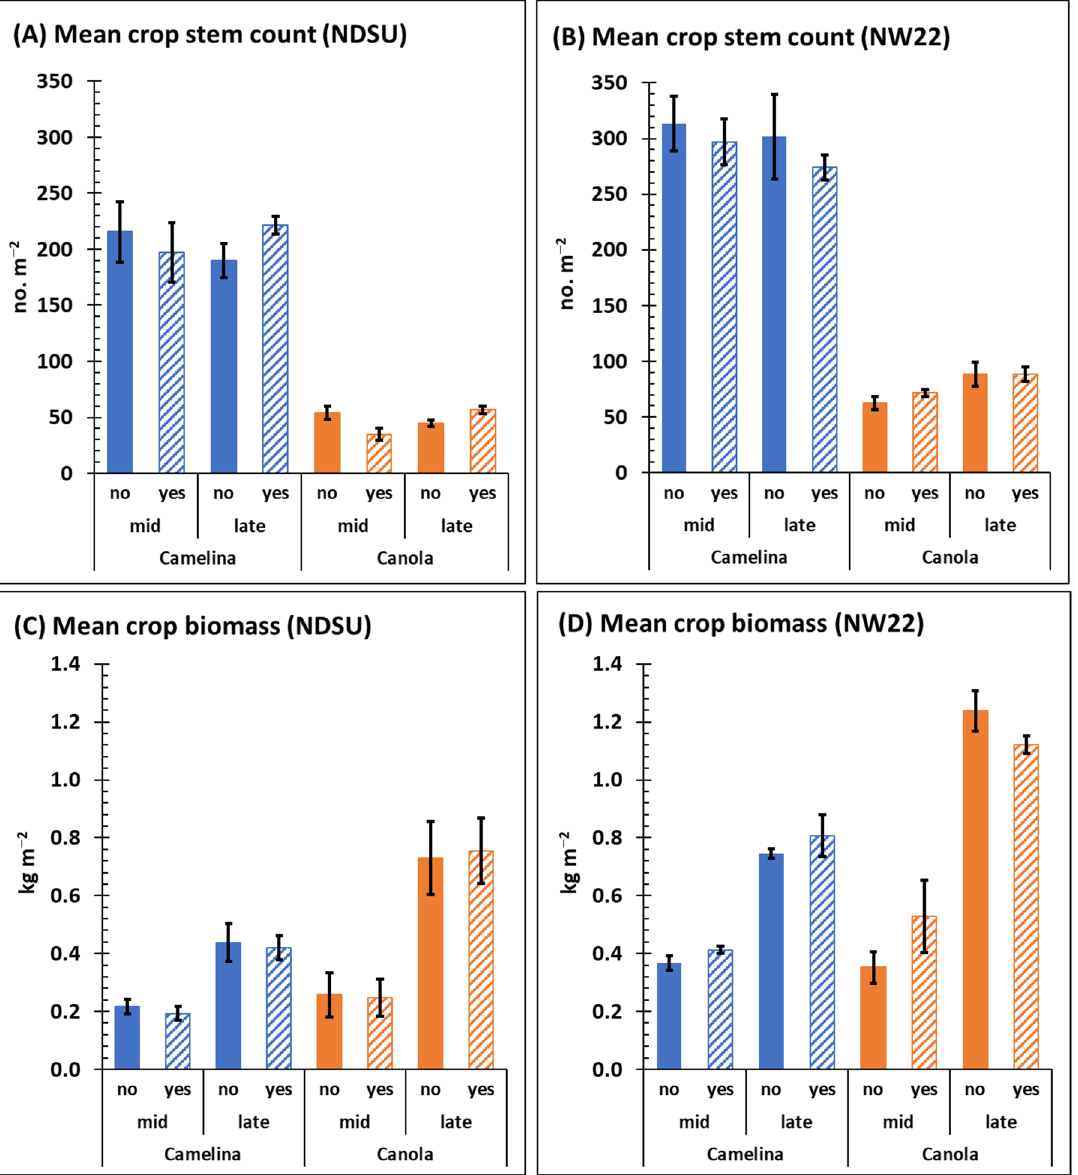
Figure 2. Mean crop stem counts ( A , B ) and biomass dry weights ( C , D ) mid- and late-season from field plot of sulfonylurea-resistant camelina and canola at NDSU ( A , C ) and NW22 ( B , D ) treated with (yes) or without (no) sulfonylurea. Error bars represent the standard error of the mean.